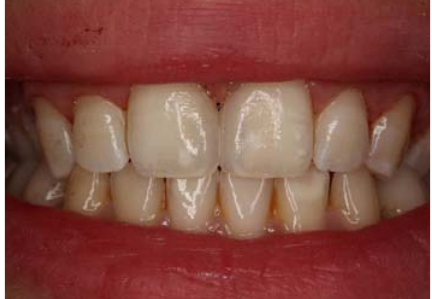
Figure 8: Postoperative view of the restorations just after removal of the rubber dam and the retraction cords.